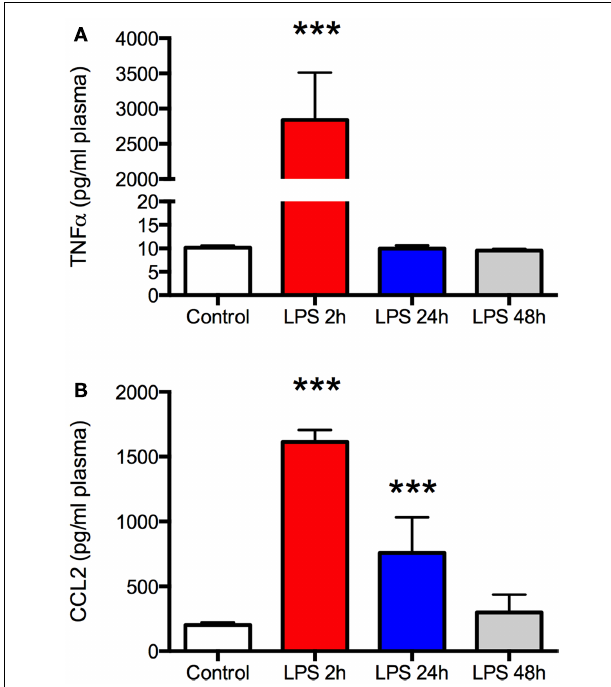
FIGURE 1 | Lipopolysaccharide (LPS) produces a robust but transient increase in plasmaTNF α and CCL2 . Plasma was sampled at the time of sacrifice from aged Fisher 344 rats 2, 24, and 48h after administration of 50 µ g/kg LPS ( N = 5 per group) or a control group ( N = 5) that received an equal volume of saline intraperitoneally.There was a marked increase in bothTNF α (A) and CCL2 (B) 2h after LPS but the effect resolved completely by 24 or 48h, respectively. Data are mean ± SEM. *** P < 0.001 by one-way ANOVA.